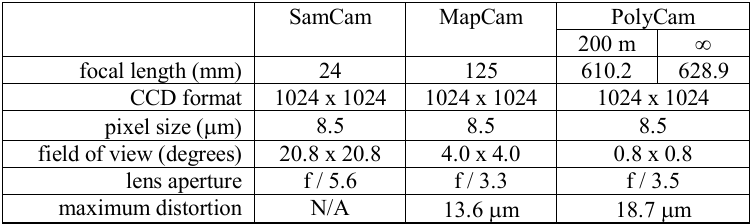
Table 1. OCAMS sensor characteristics. PolyCam focal lengths are given at either end of the focal range. SamCam lens distortion is yet to be determined.